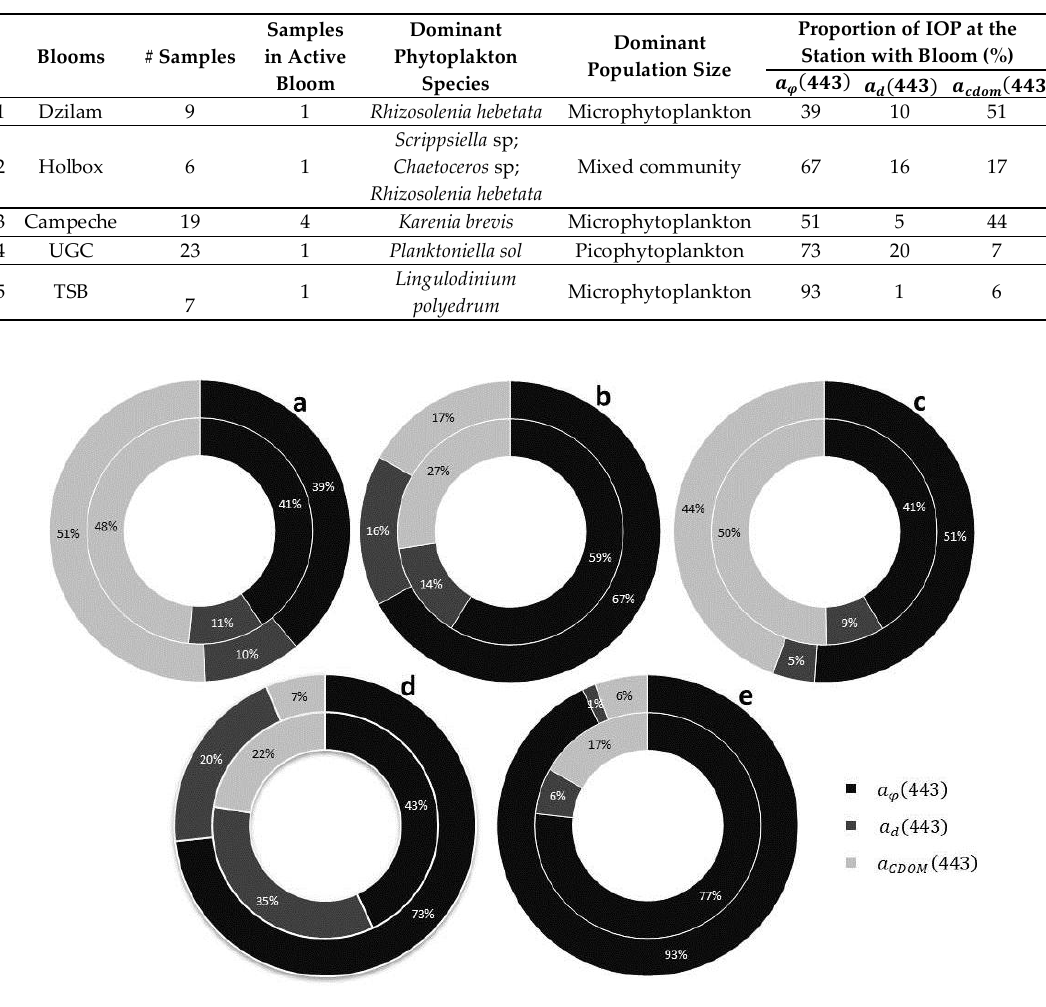
Figure 2. Contribution of each absorption coefficient ( 𝑎 𝜑 ( 443 ) , 𝑎 𝑑 ( 443 ) and 𝑎 𝑐𝑑𝑜𝑚 ( 443 ) ) to 𝑎 ( 443 ) for each sampling area. The inner circumference shows the average contribution of each absorption coefficient to 𝑎(443) for each sampling campaign. The outer circumference represents the average value of sampling points classified as active bloom according to the IOP index. ( a ) Dzilam de Bravo ( b ) Holbox; ( c ) Campeche Bay; ( d ) Upper Gulf of California; ( e ) Todos Santos